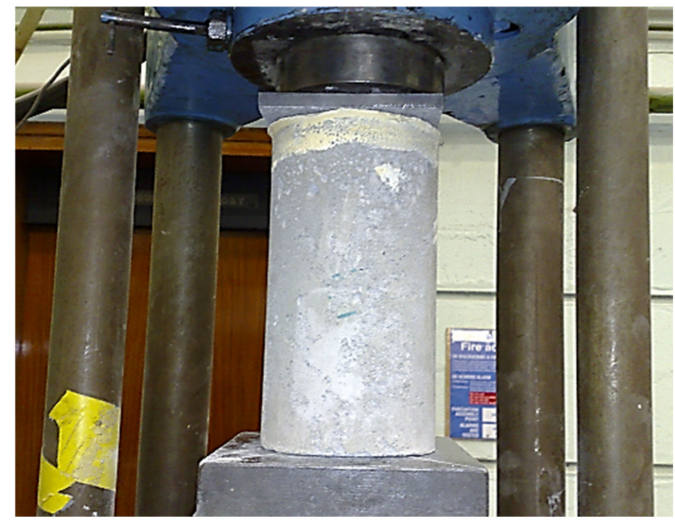
Figure 4. Setup for axial compression test to determine the compressive strength of LFC.